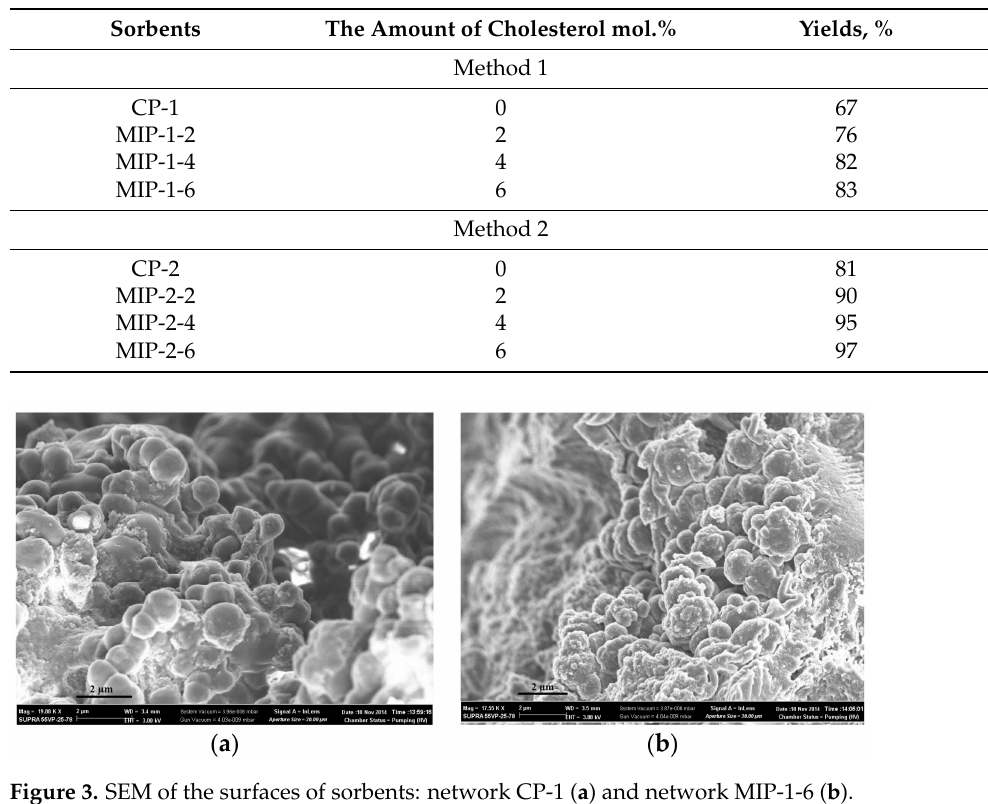
Table 1. Yields of synthesized sorbents.